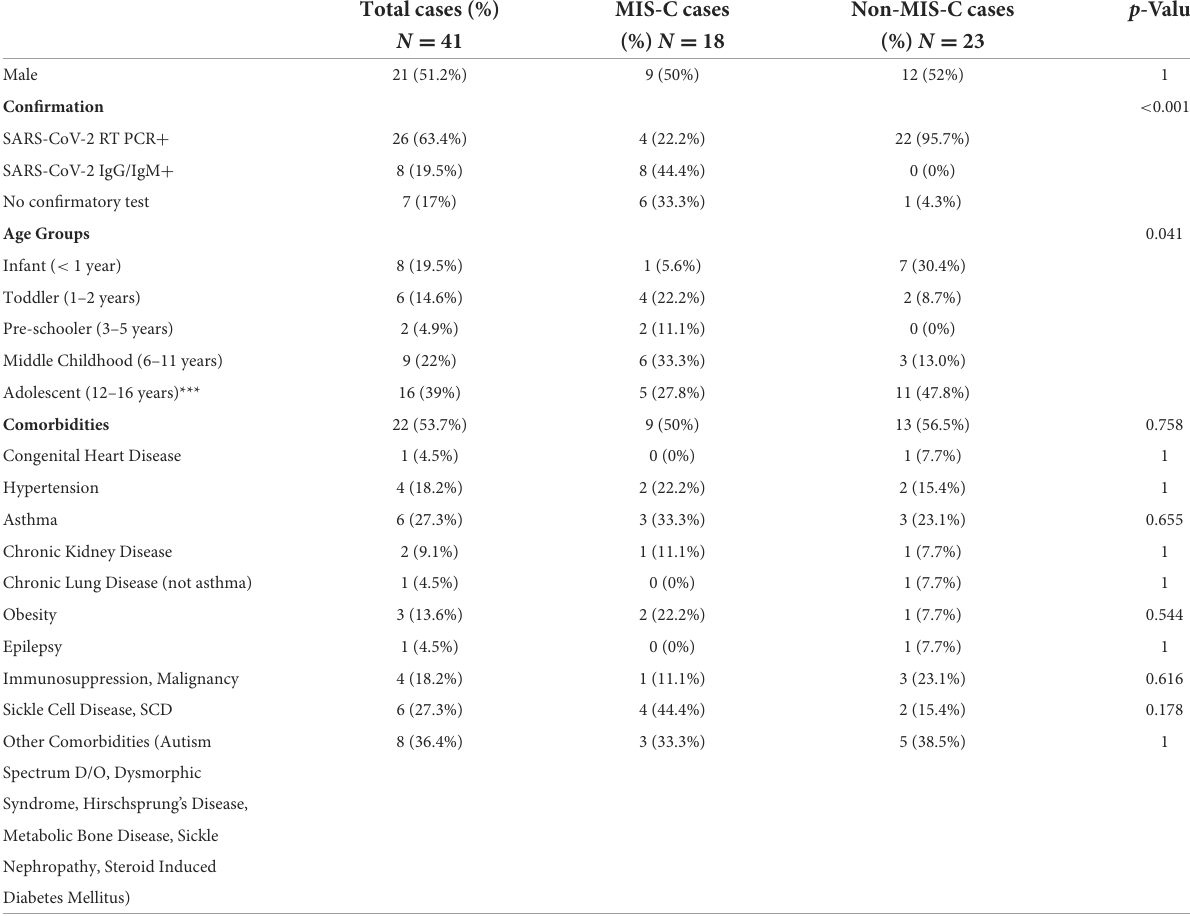
TABLE 1 Characteristics of children hospitalized with COVID-19, MIS-C * vs